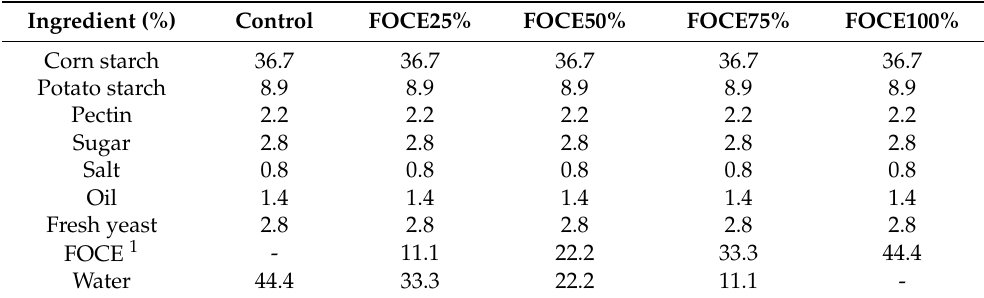
Table 5. Composition of experimental gluten-free